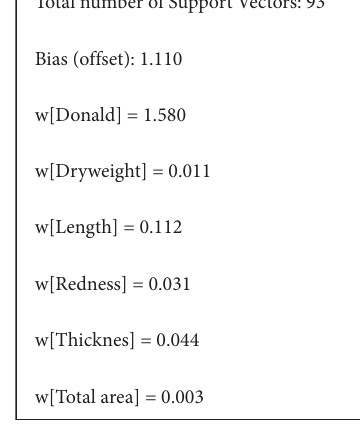
Figure 3: Support vector machine (SVM)